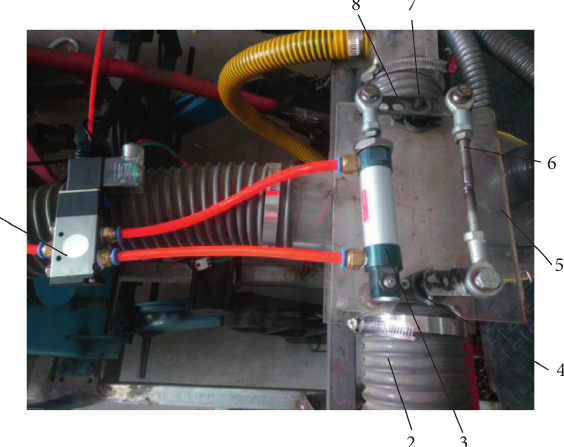
Figure 9: Physical map of the switch device. (1) Electromagnetic valve. (2) Three-way switch device. (3) Cylinder. (4) Bearing. (5) Fixed frame of three-way switch device. (6) Link. (7) Axis of ro- tation. (8)